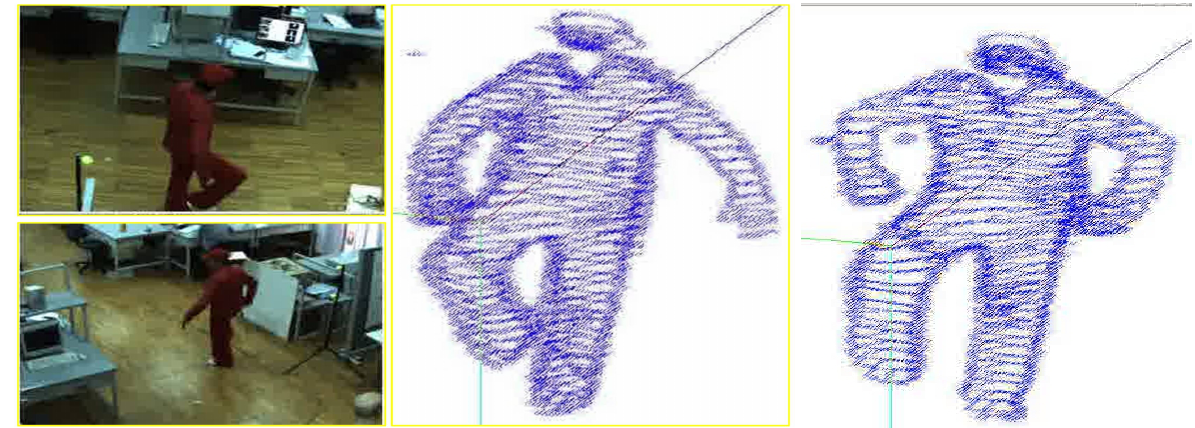
Figure 13. Dynamic movement of a person under our 3D reconstruction framework.